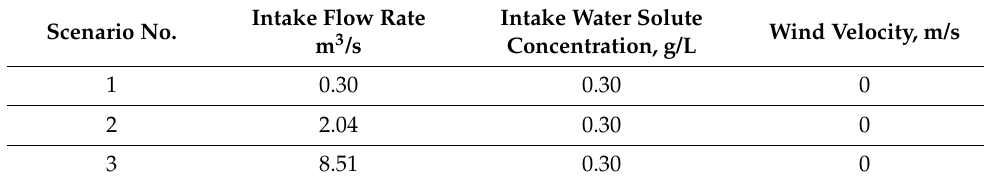
Table 2. The numerical setup used for 2D and 3D simulations. Scenario